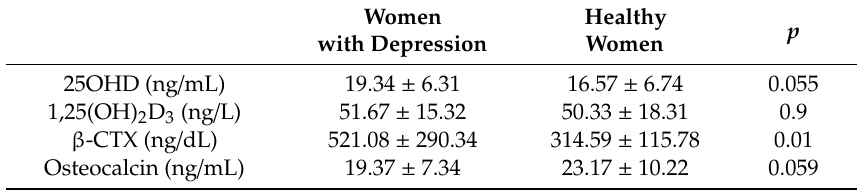
Table 3. Vitamin D and bone markers in women with depression and healthy controls. Data presented as the mean ± SD; 25OHD—25-hydroxyvitamin D; 1,25(OH) 2 D 3 —1,25-dihydroxyvitamin D 3